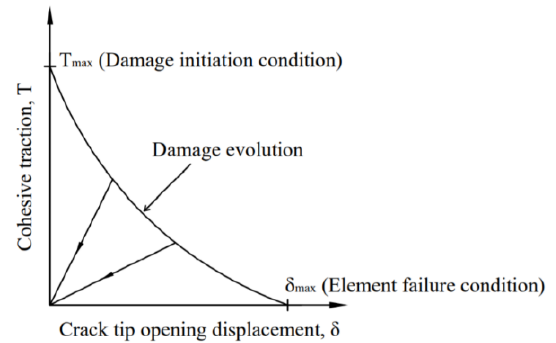
Figure 9. The traction-separation law.